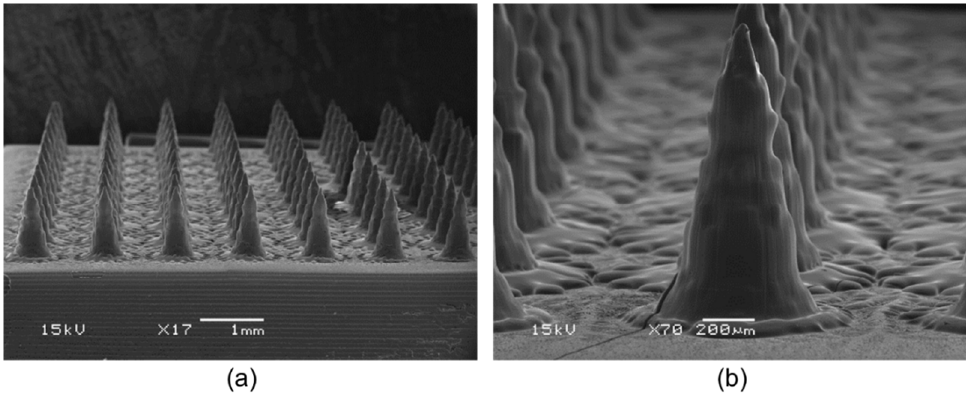
Figure 3. Typical SEM photomicrograph of donepezil-loaded DMN patch (acceleration voltage 15 kV). Arrangement of microneedles in ( a ) the patch with a scale bar of 1 mm and ( b ) a single needle with scale bar of 200 µm.